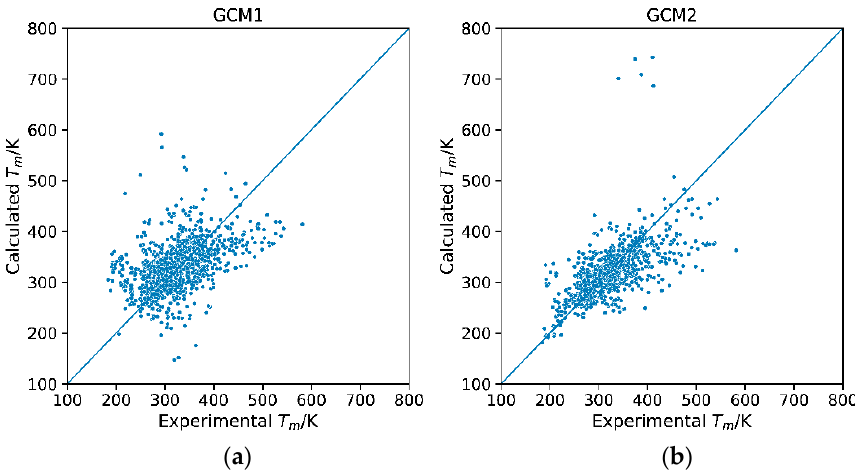
Figure 1. Parity plots of calculated versus experimental melting points for ( a ) GCM1 and ( b ).